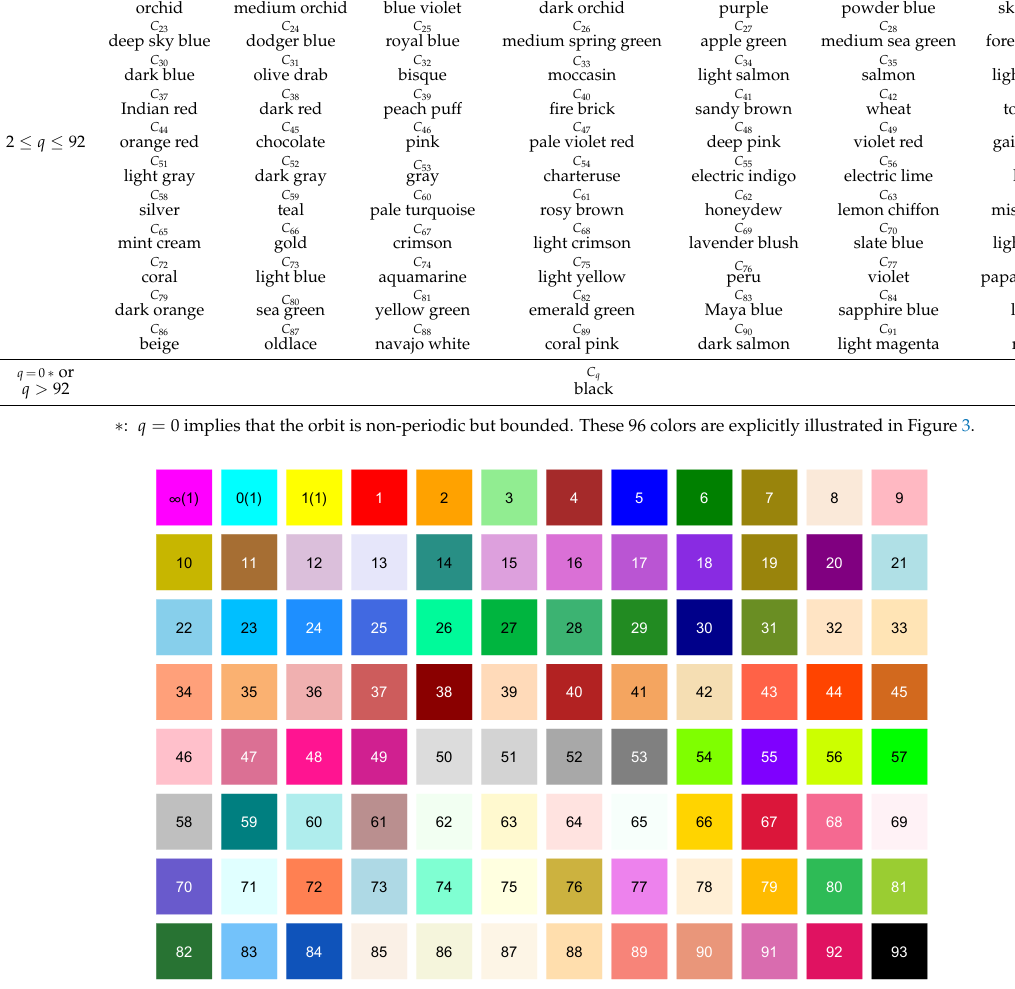
Figure 3. Color chart defined in Table